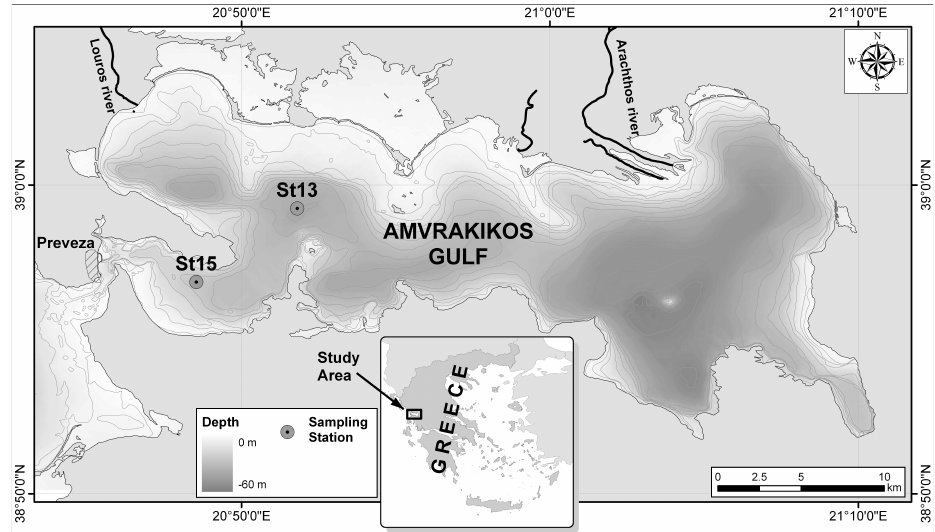
Fig. 1. Map of Amvrakikos Gulf, Greece. The major rivers (Louros and Arachthos Rivers), the Preveza Strait (connection with the Ionian Sea) and the sampling stations of cores Amvr13 and Amvr15 are